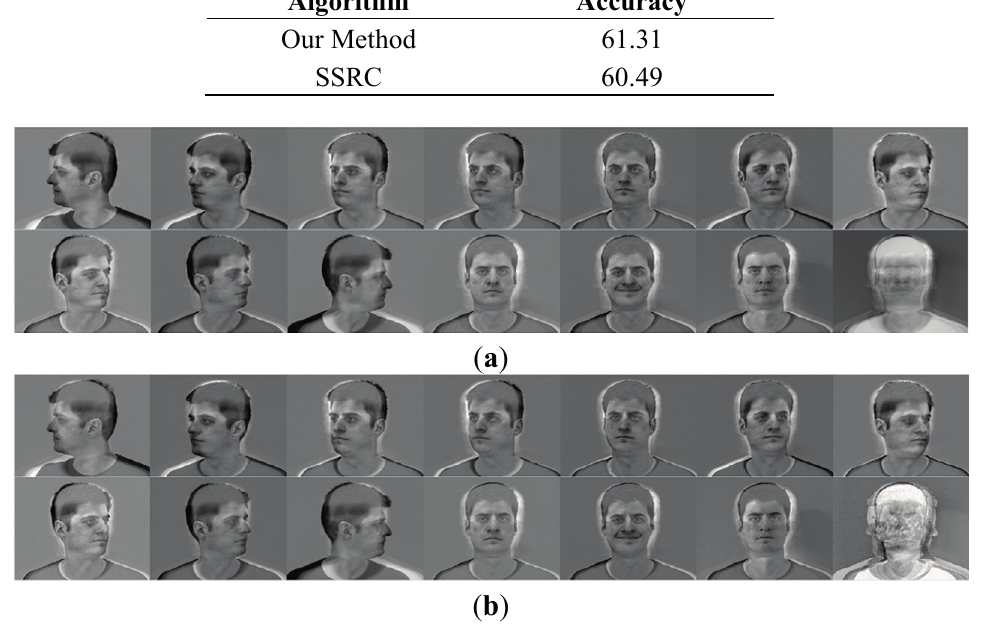
Figure 9. The illustrative examples of the facial variation model based on FEI database. ( a ) The intra-class difference of the “sample-to-centroid” variation images of SSRC method; ( b ) The intra-class difference of the “sample-to-centroid” variation images of our